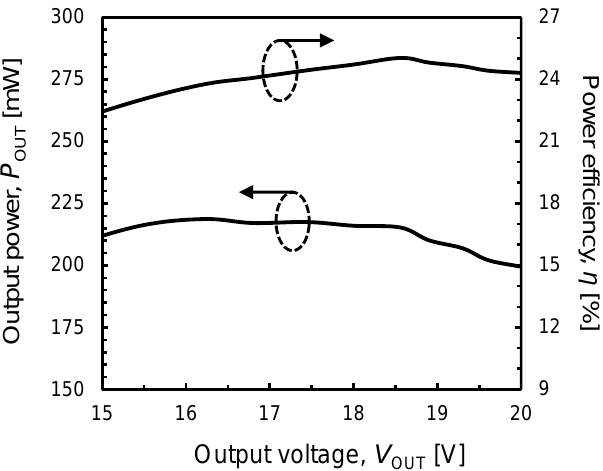
Figure 12. Power efficiency, η , and output power, P OUT , vs. isolated output power.